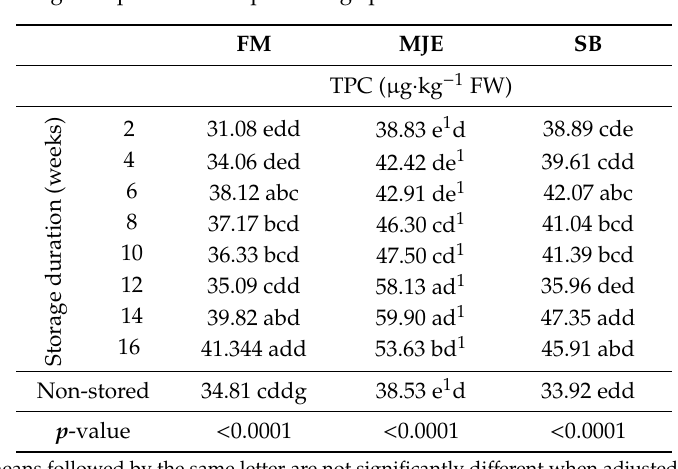
Table 5. Total phenolic content (TPC) gallic acid equivalent in petals of Paeonia lactiflora cultivars Festiva Maxima (FM), Monsieur Jules Elie (MJE), and ‘Sarah Bernhardt’ (SB) in response to storage duration independent of storage temperature and pre-storage